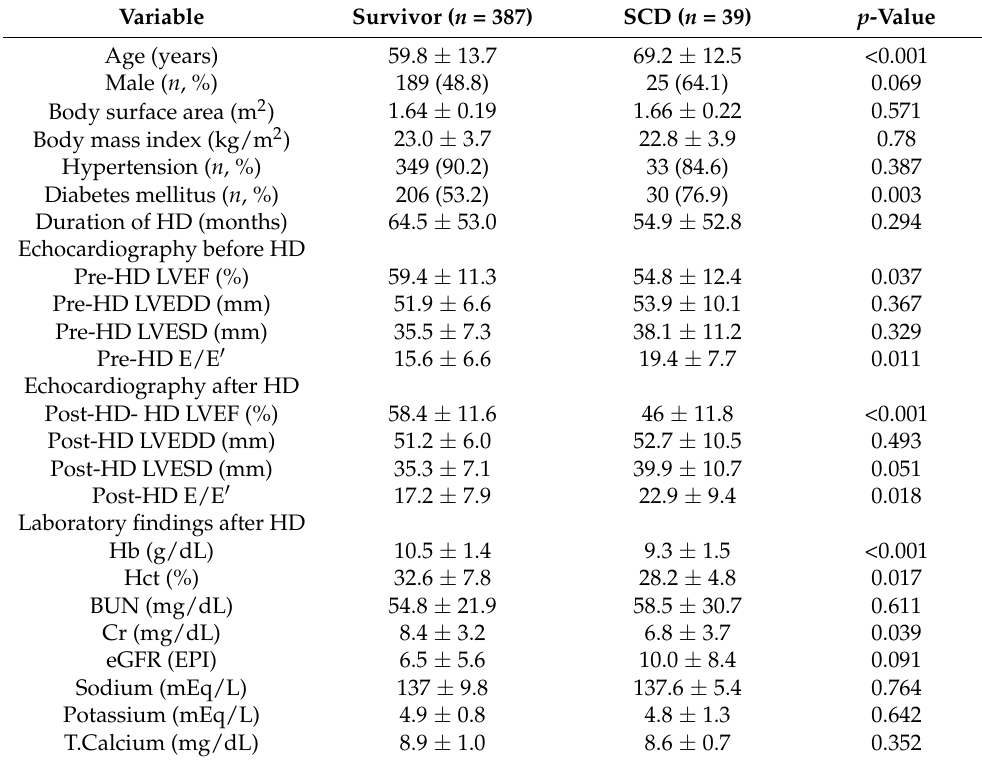
Table 1. Baseline characteristics of the